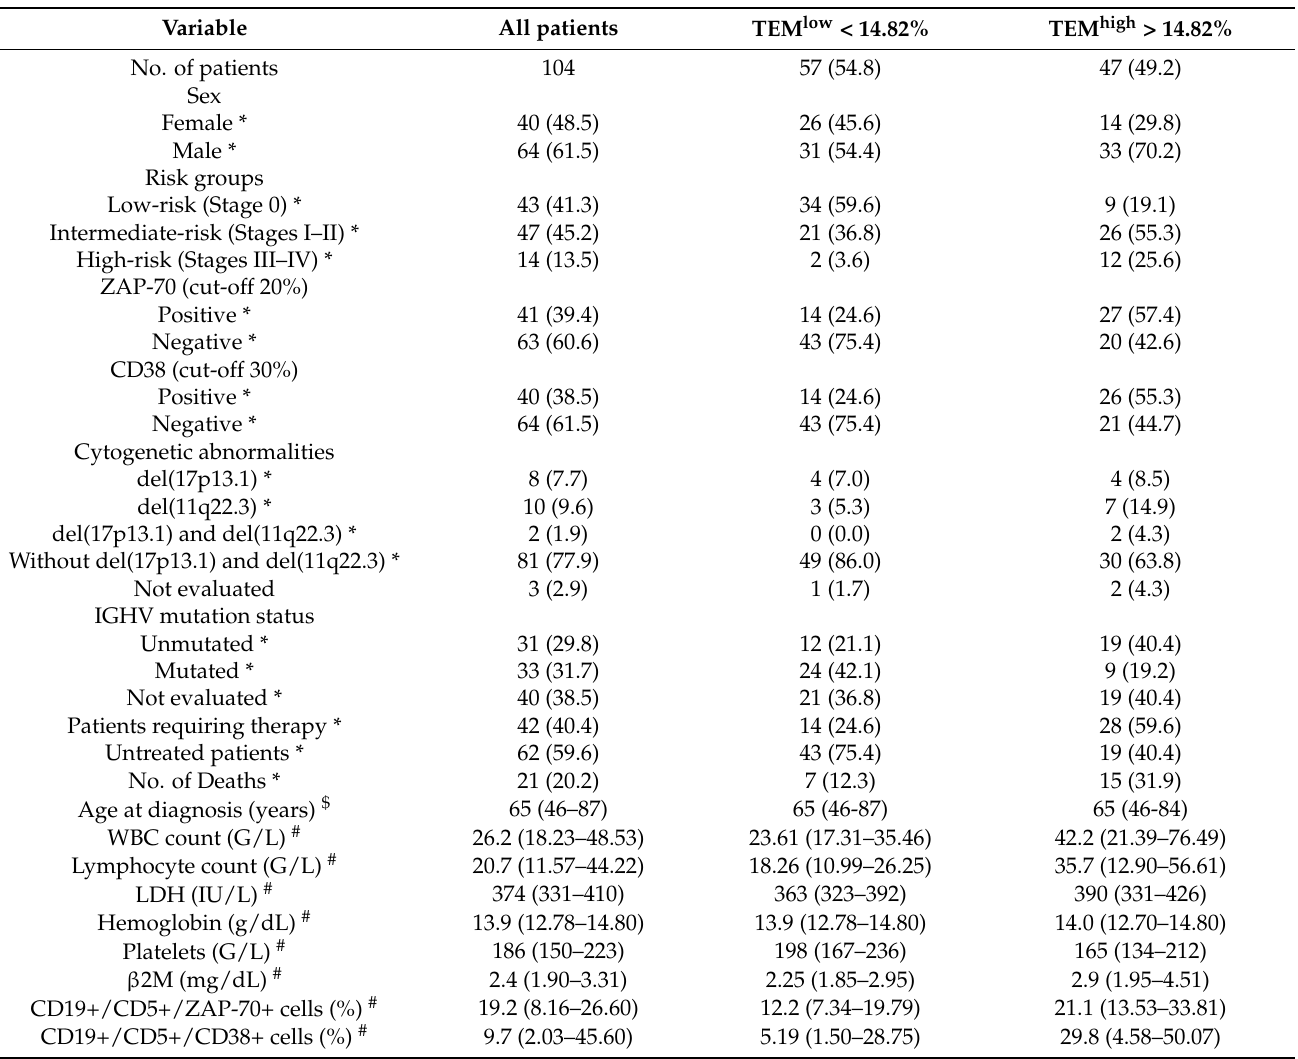
Table 1. Baseline characteristics at the time of diagnosis for CLL